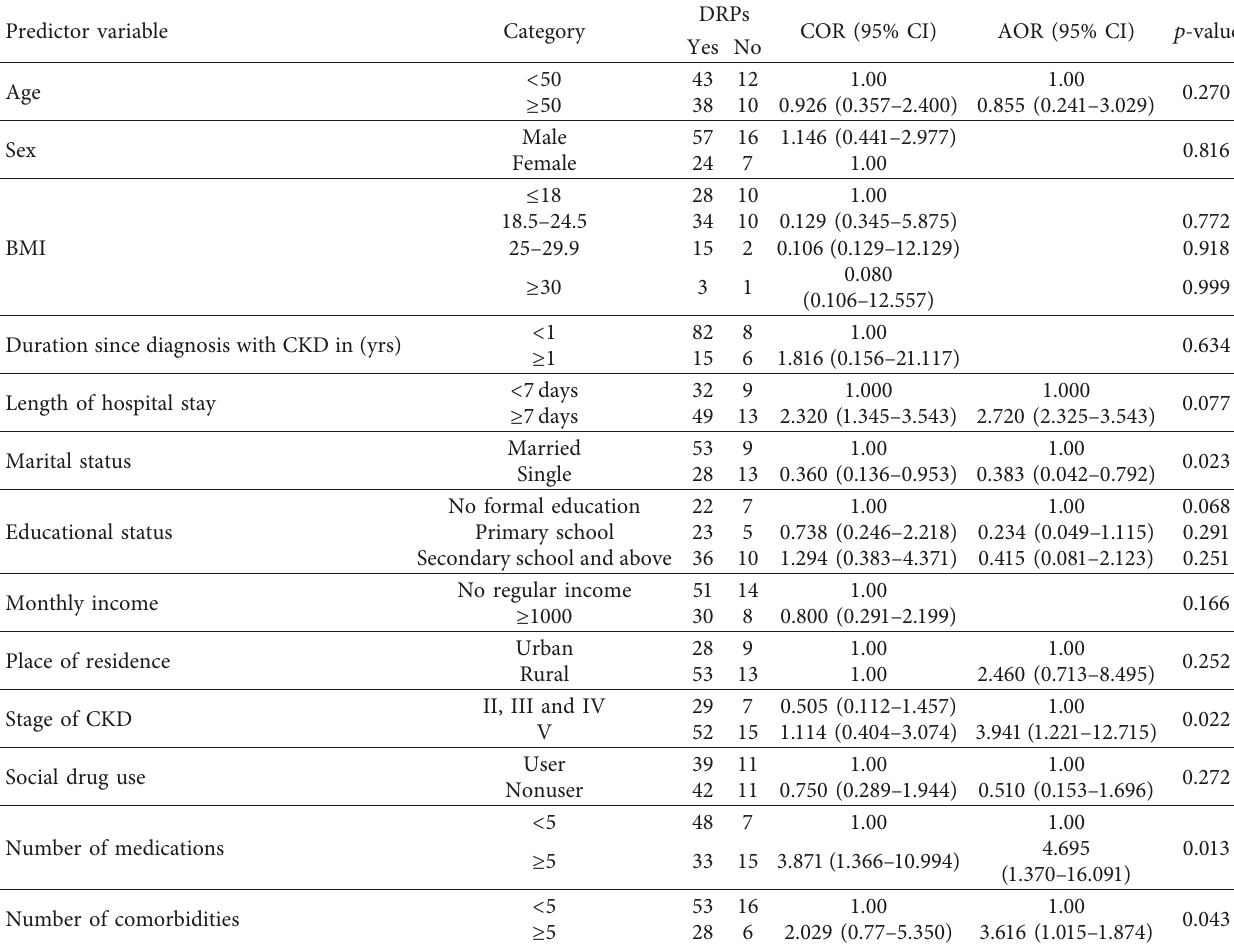
Table 6: Binary logistic regression result of predictors of MRPs among CKD patients at JUMC, Jimma Zone, Jimma, Southwest Ethiopia, from April 1 to September 30,